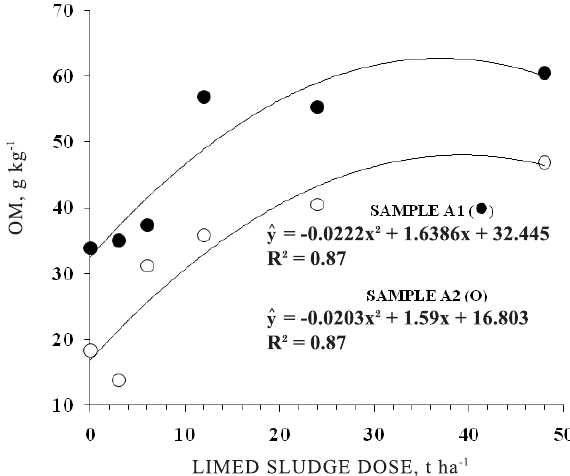
Figure 4. Organic matter (OM) content as related to the dose of limed sludge (50 %) applied to soil samples A1 (very clayey texture) and A2 (medium texture) in this